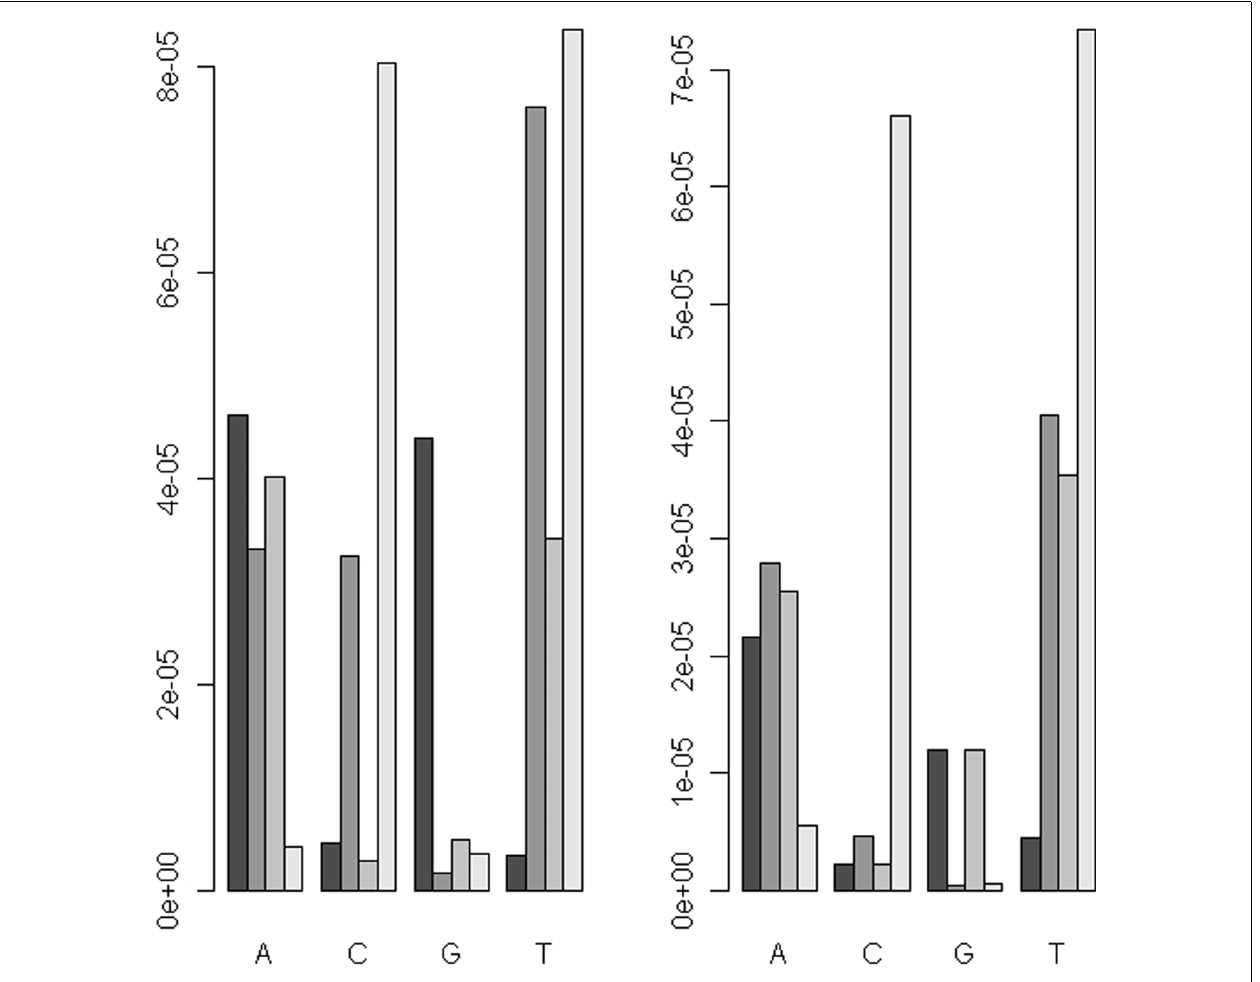
FIGURE 3 |The absolute differences of the base-calling rates between two replicates (| (cid:2) |) for the pooled DNA before amplification (left panel) and the pooled PCR products (right